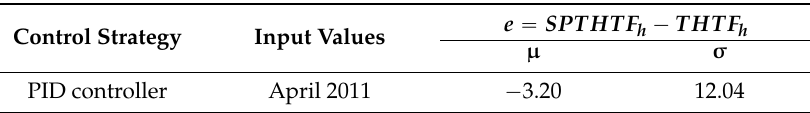
Table 5. Numerical results of simulation with PID (April 2011).